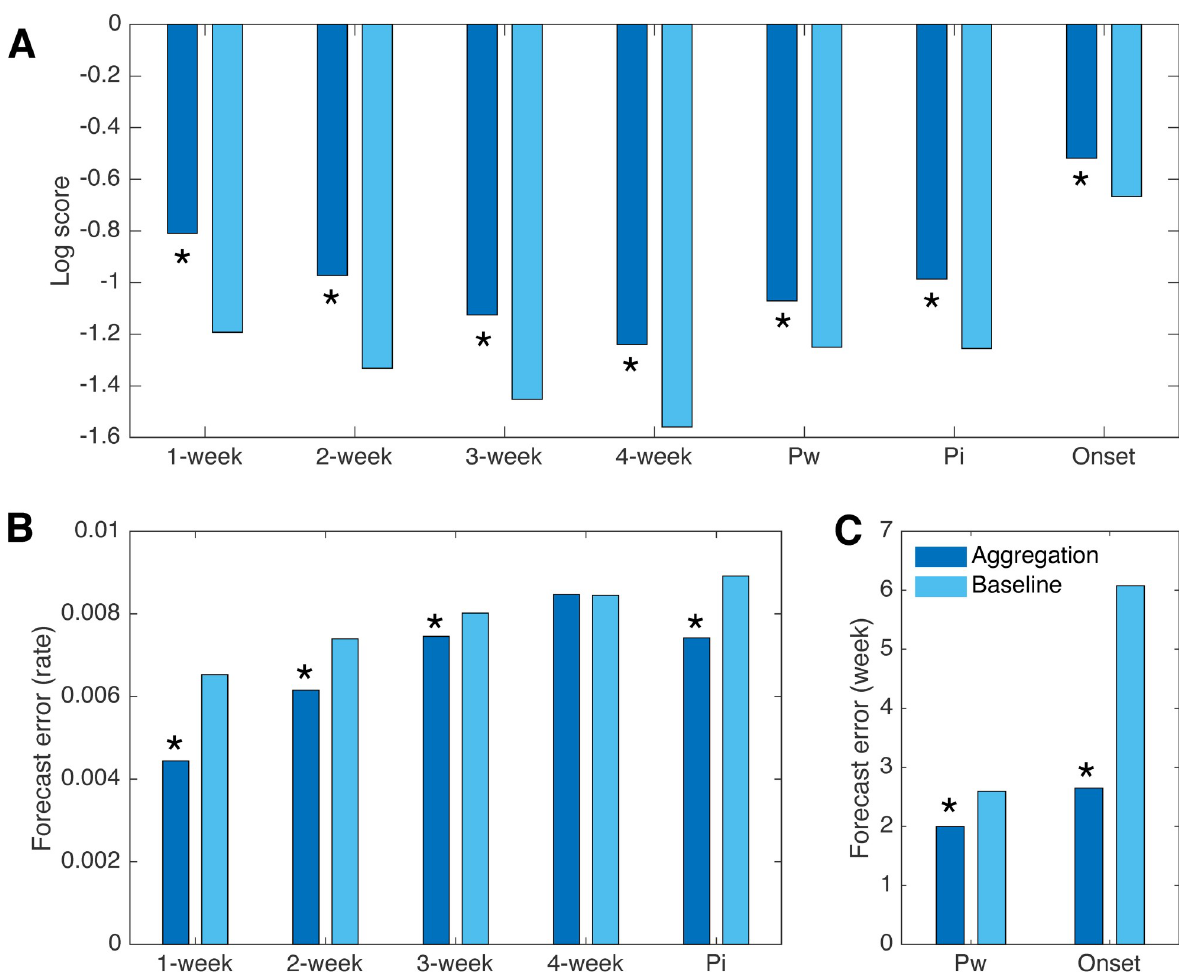
Fig 4. Comparison of forecast performance with the baseline method. Comparisons of log scores for forecasts generated by aggregating multiple pathogens and the baseline method that simulates ILI as a single agent (A). Log scores are obtained from weekly retrospective forecasts for ILI at the national level and in HHS regions 1 to 9, from 1997–1998 to 2013–2014 seasons, excluding pandemic seasons 2008–2009 and 2009–2010. Four near-term targets (1- to 4-week ahead ILI) and three seasonal targets (peak week, peak intensity and onset week, denoted by Pw, Pi and Onset, respectively) are shown. Comparison of forecast error for predictions of 1- to 4-week ahead ILI and peak intensity (B). Comparison of forecast error for predictions of peak week and onset week (C). Asterisks indicate statistical significance for multi-pathogen forecasts outperforming baseline ( p < 10 − 5 , Wilcoxon signed-rank